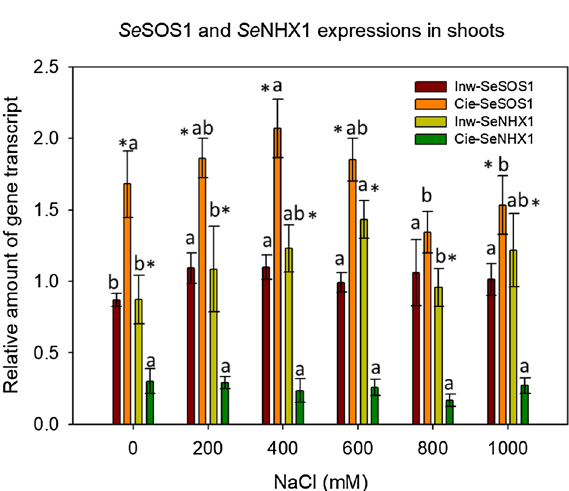
Figure 7. ( a ) Bi-plot of the first two principal components with all variables and observations, showing distribution of samples along the gradient of salinity going from right to left. ( b ) Three main principal components represented in a 3D plot showing distances per treatment among both populations. Inw Inowrocław, Cie Ciechocinek, 0, 200, 400, 600, 800 and 1000 indicate the concentrations in mM of NaCl, and PC the corresponding principal component.